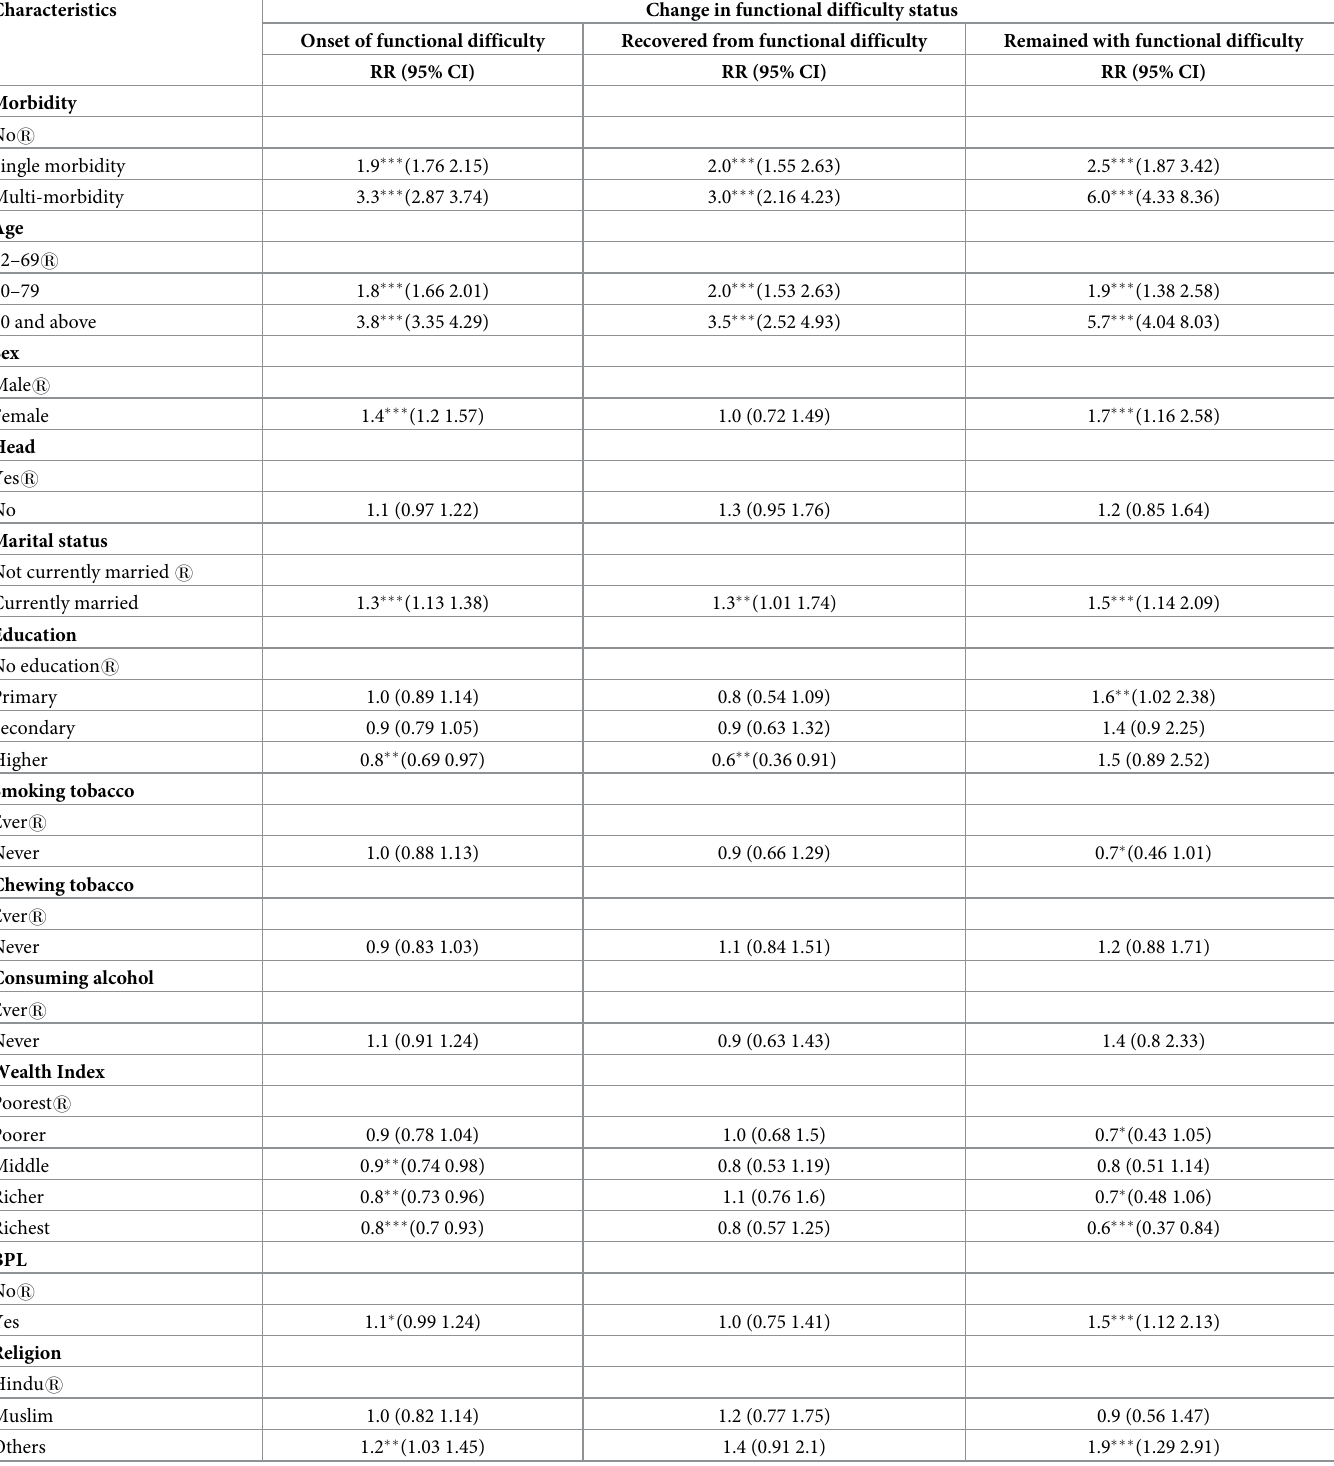
Table 3. Relative risk ratio from multinomial logistic regression showing the association of multi-morbidity with onset, recovery from and remaining with func- tional difficulty among older adults (ref: No functional difficulty in both rounds) by background characteristics.